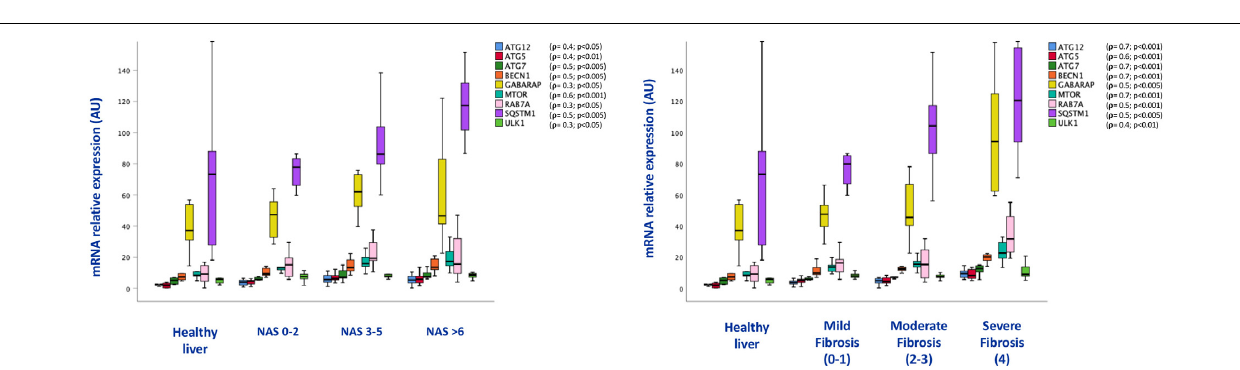
autophagy in NAFLD, leading to impaired lipid